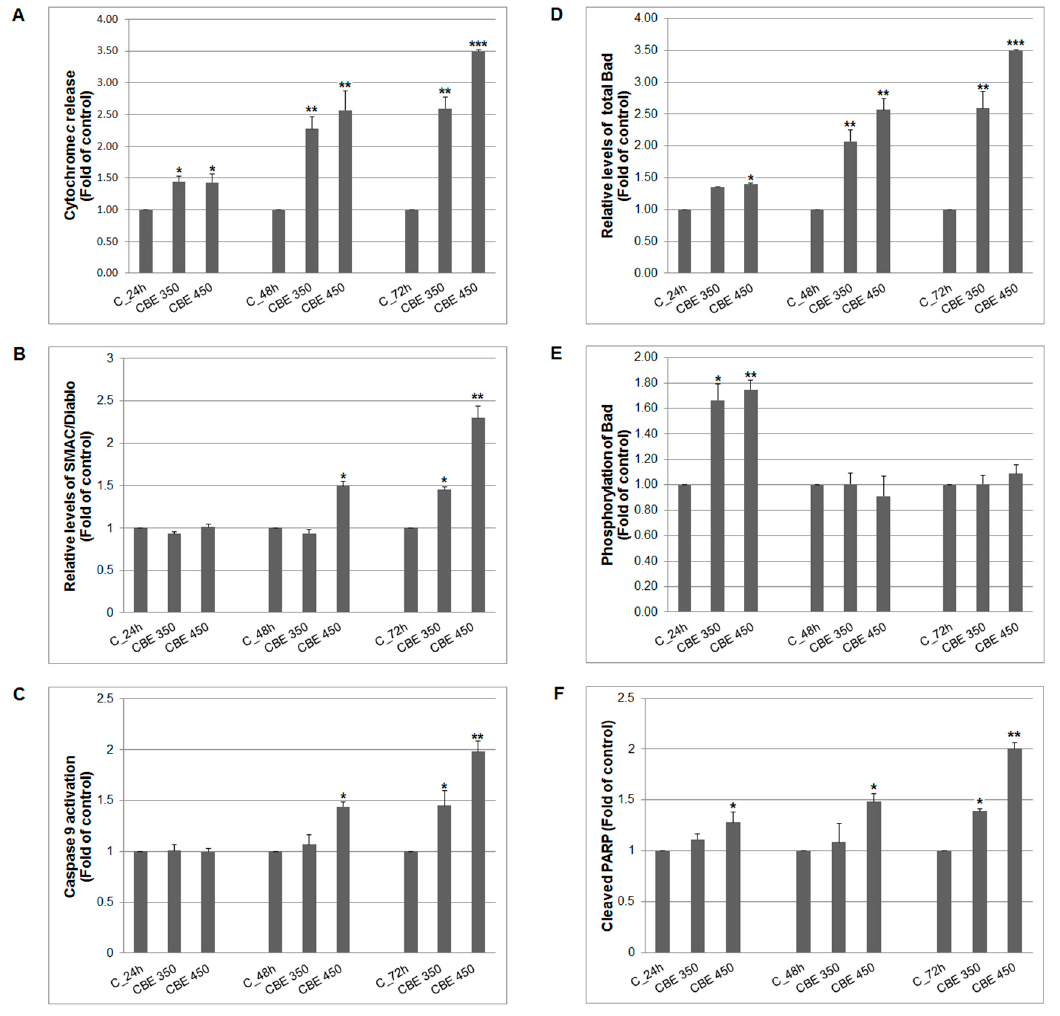
Figure 2. Effect of CBE on ( A ) cytochrome c release, ( B ) SMAC/Diablo expression, ( C ) caspase-9 activation, ( D , E ) Bad activity and cleaved PARP ( F ) in MCF-7 cells. Data were obtained from three independent flow cytometry experiments after 24, 48 and 72 h of CBE treatment. Significance: * p < 0.05, ** p < 0.01, *** p < 0.001 vs. untreated cells (control).